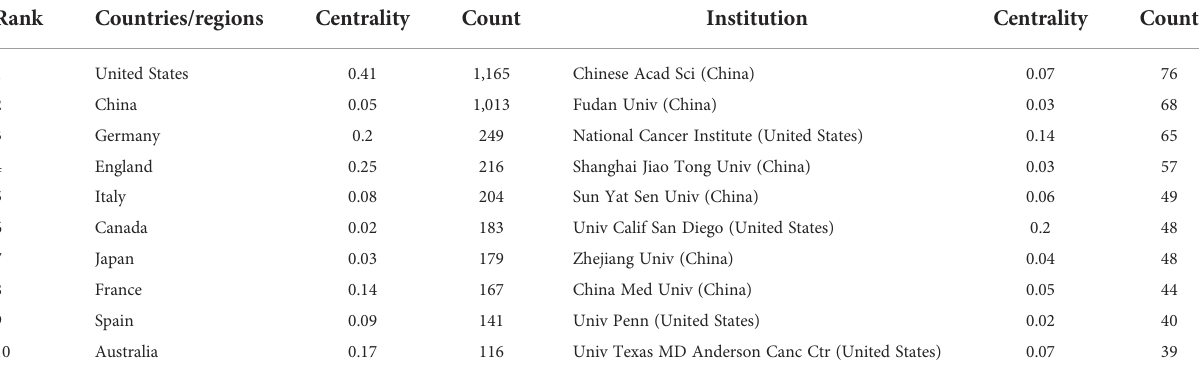
TABLE 1 Top 10 countries/regions and academic institutions involved in alternative splicing of cancer